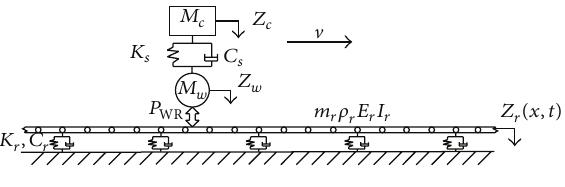
Figure 6: Wheel-rail contact